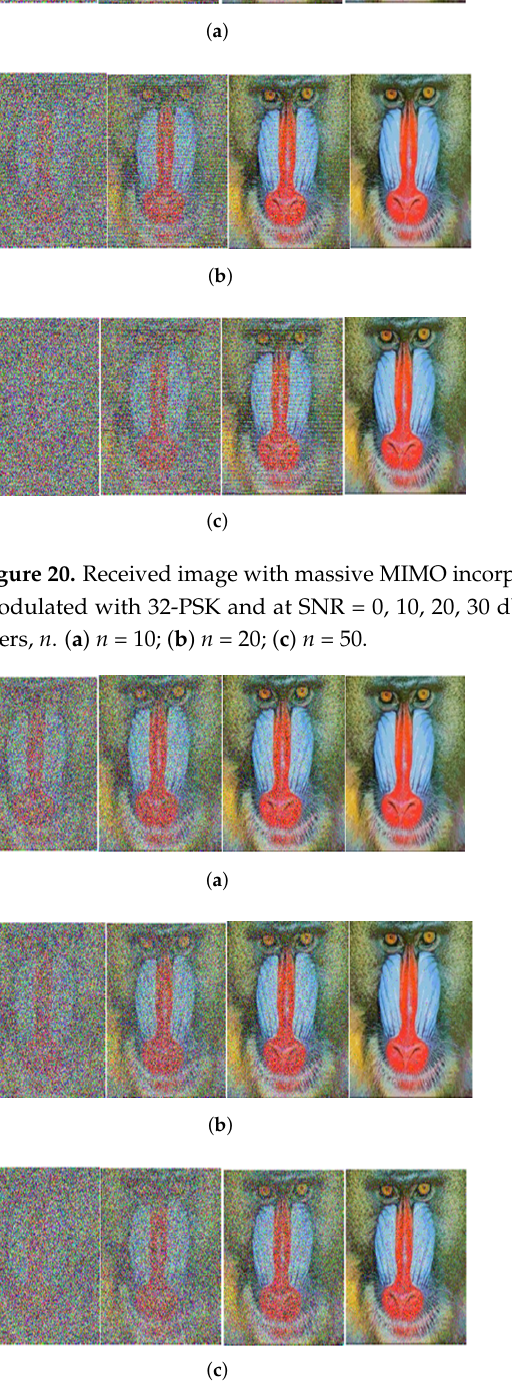
Figure 21. Received image with massive MIMO incorporated DWT-OFDM over a Rayleigh channel, Modulated with 64-PSK and at SNR = 0, 10, 20, 30 dB from Left to Right for different number of users, n . ( a ) n = 10; ( b ) n = 20; ( c ) n =